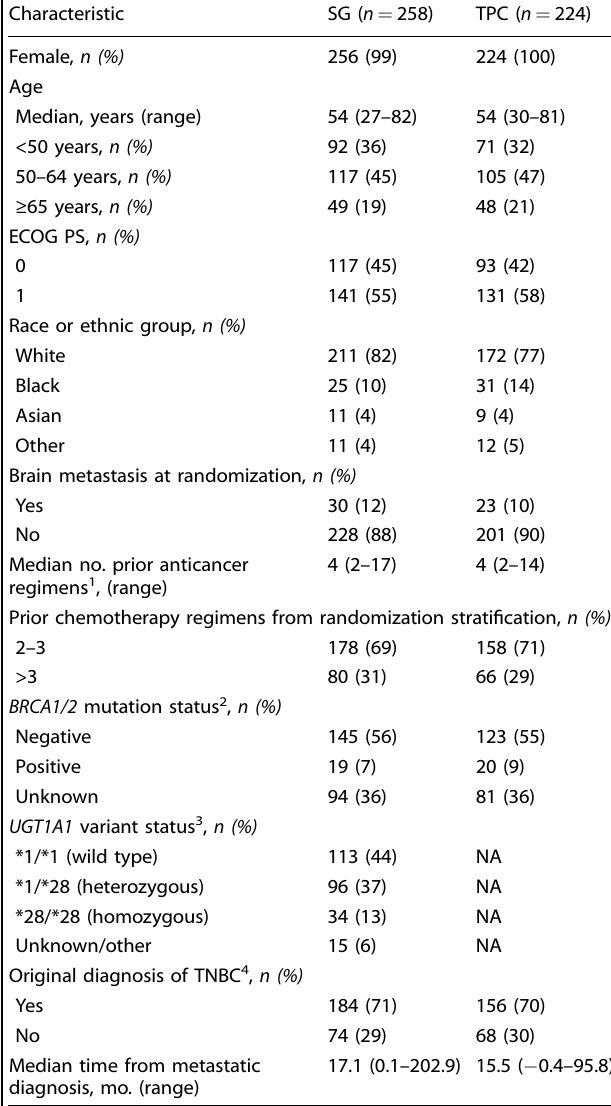
Table 1. Patient demographics and disease characteristics at baseline (Safety